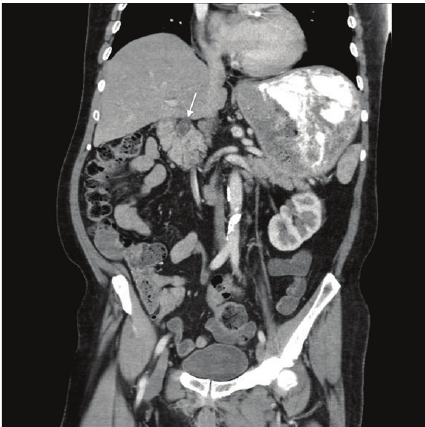
Figure 5: Sagittal view showing 1.6cm common bile duct stone (arrow) with associated 1.6 cm common bile duct dilatation and minimal intrahepatic biliary ductal dilatation. Again, oral contrast only in the region of the gastric fundus, decompressed loops of bowel, and a small bowel feces sign in the region of the pylorus and the proximal duodenum are